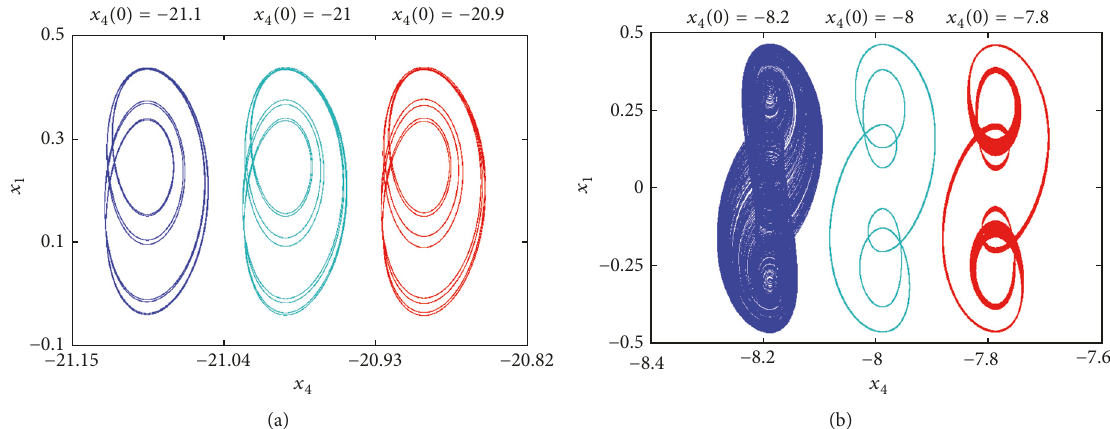
Figure 6: Disconnected phase portraits in the x 1 ( t )- x 4 ( t ) plane with different x 4 (0), where x 1 (0) = 0, x 2 (0) = 0.1, and x 3 (0) = 0. (a) Period-4 limit cycles with similar topologies but different locations under x 4 (0) = − 21.1/ − 21/ − 20.9. (b) Chaotic and periodic attractors with different topologies and locations under x 4 (0) = − 8.2/ − 8/ − 7.8.